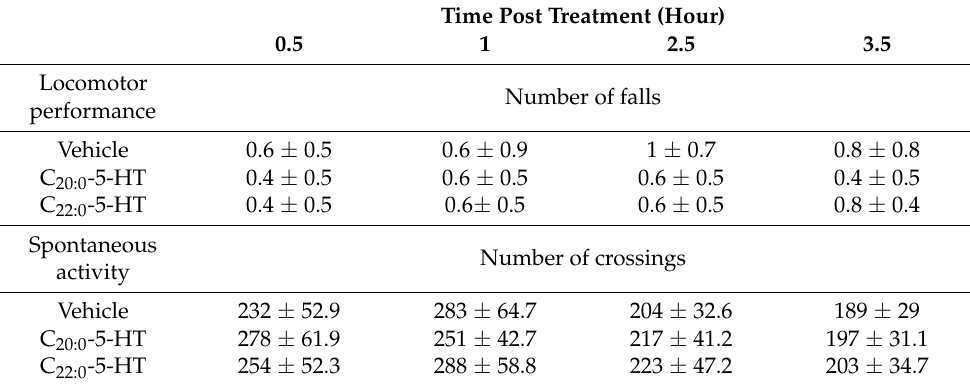
Table 2. Effect of β N -alkanoyl-5-hydroxytryptamides in spontaneous activity and locomotor perfor- mance of mice.